Question: Compose a caption that would accompany this figure in a paper.
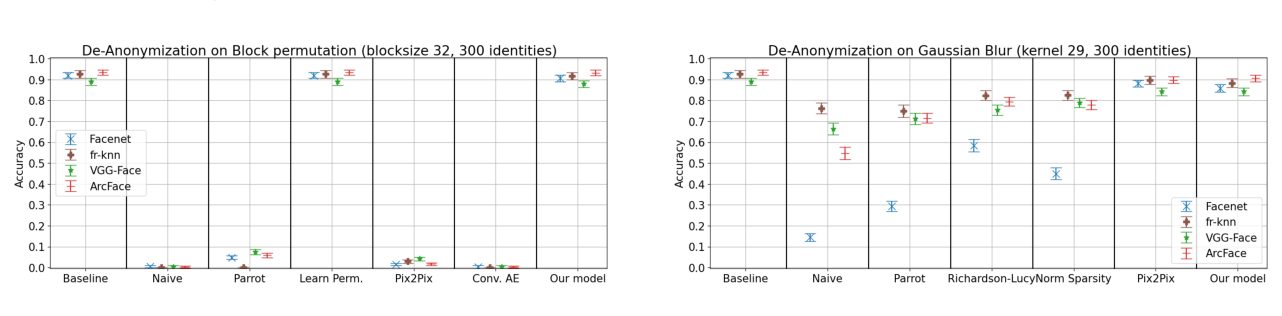
Answer: Recognition accuracy for Block Permutation (block- size 32), given for baseline, naive, parrot, de-anon. via learn permutation, via Pix2Pix, via Conv. AE (our model without linear layer), and via our model; on 300 identities of CelebA.